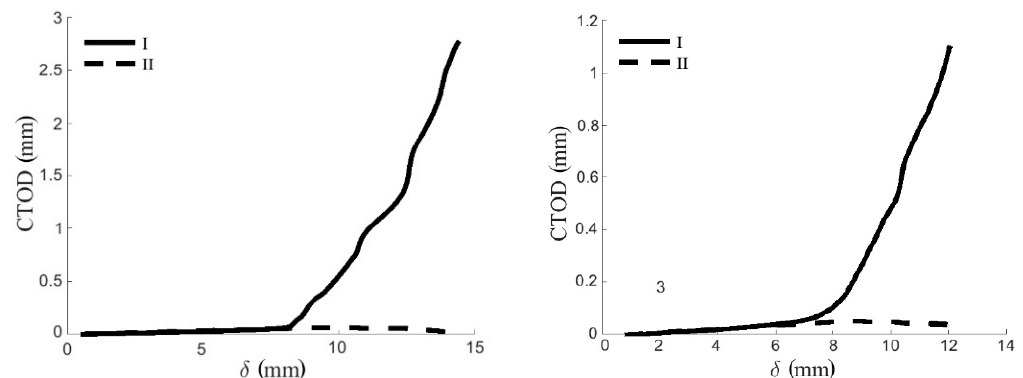
Figure 7. Normal and transverse crack tip opening displacements (CTOD) measured by DIC from a representative DCB test in RL ( left ) and TL ( right ) crack propagation systems.